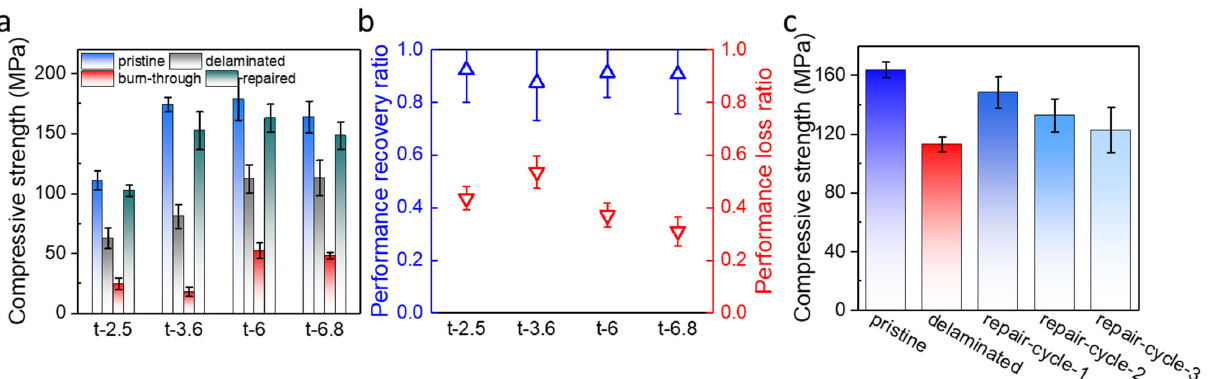
Figure 5. ( a ) Compressive strength of the panels with four thicknesses under different statues. ( b ) Performance recovery ratio and loss ratio as a function of sample thickness. ( c ) Compressive strength of a t ‐ 6.8 CF/epoxy panel under three delamination–repair